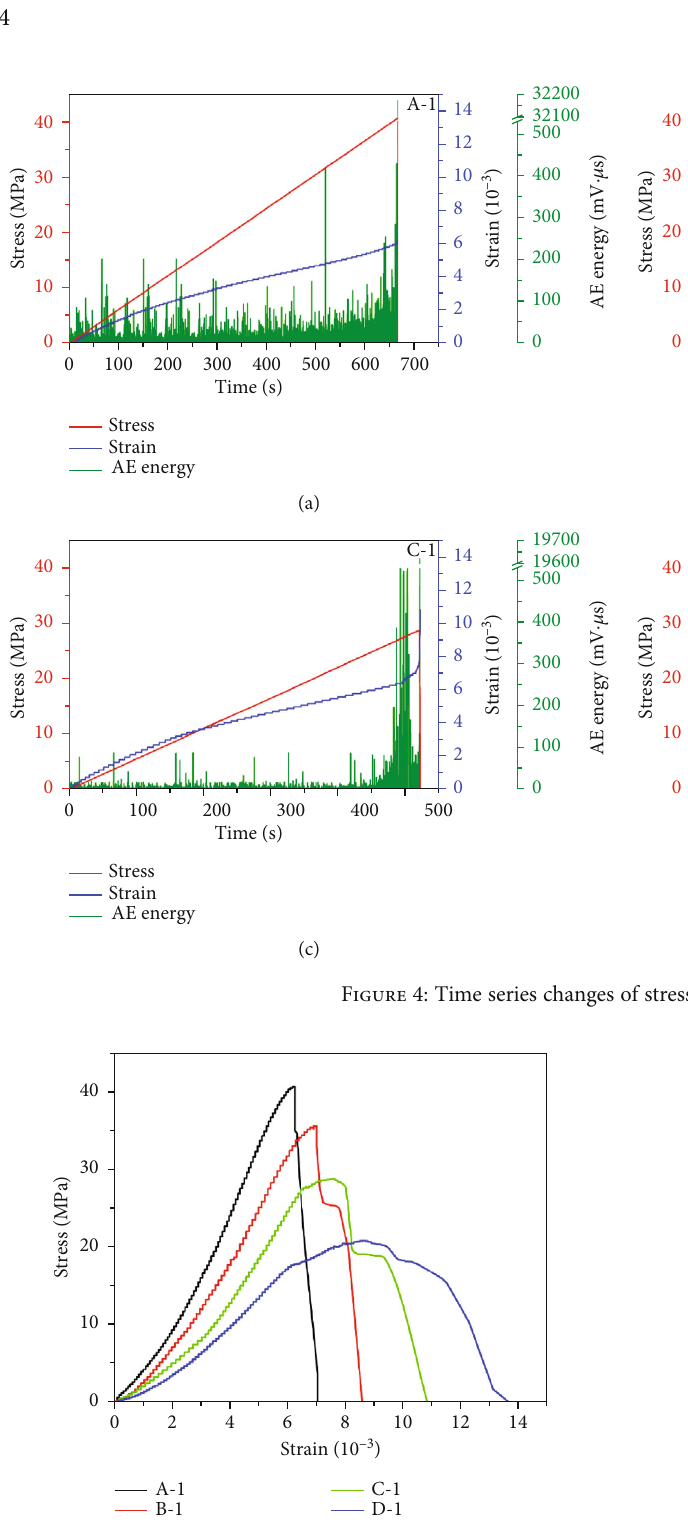
Figure 5: Stress-strain curve. Figure 6: Time series change of cumulative AE